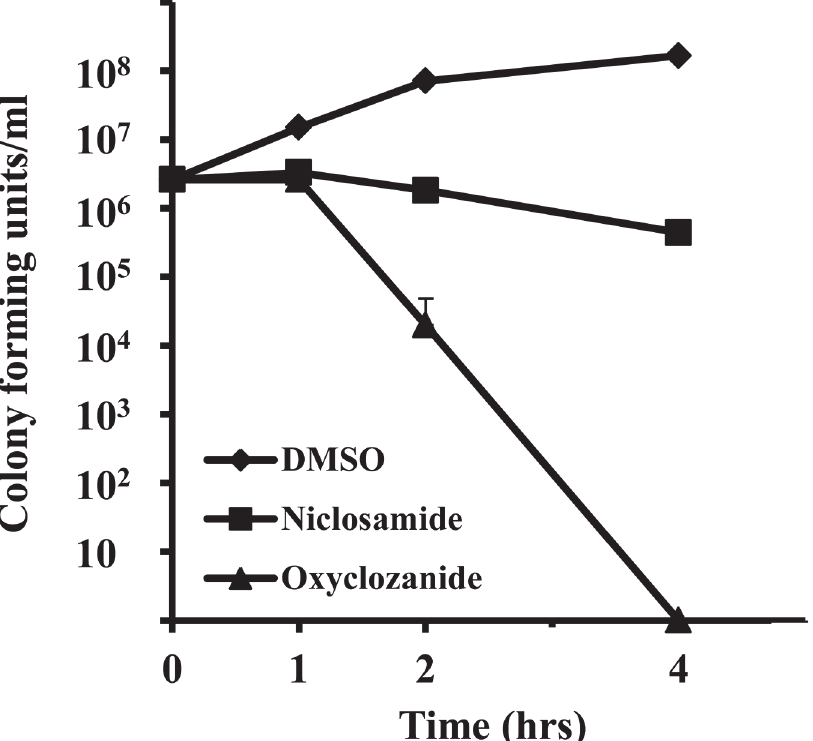
Fig 4. Comparative time-kill kinetics of niclosamide and oxyclozanide against MRSA. The survival of MW2 in a broth culture treated with DMSO, niclosamide or oxyclozanide at a concentration of 4 times the MIC. (MIC values: niclosamide 0.125 μ g/ml, oxyclozanide 0.5 μ g/ml).